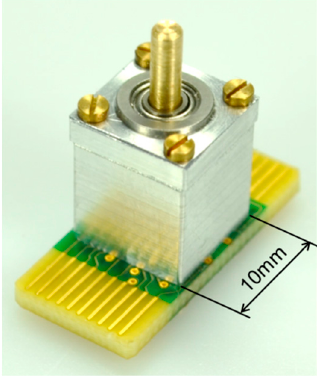
Figure 19. Completely assembled demonstrator for the miniaturized optical encoder.